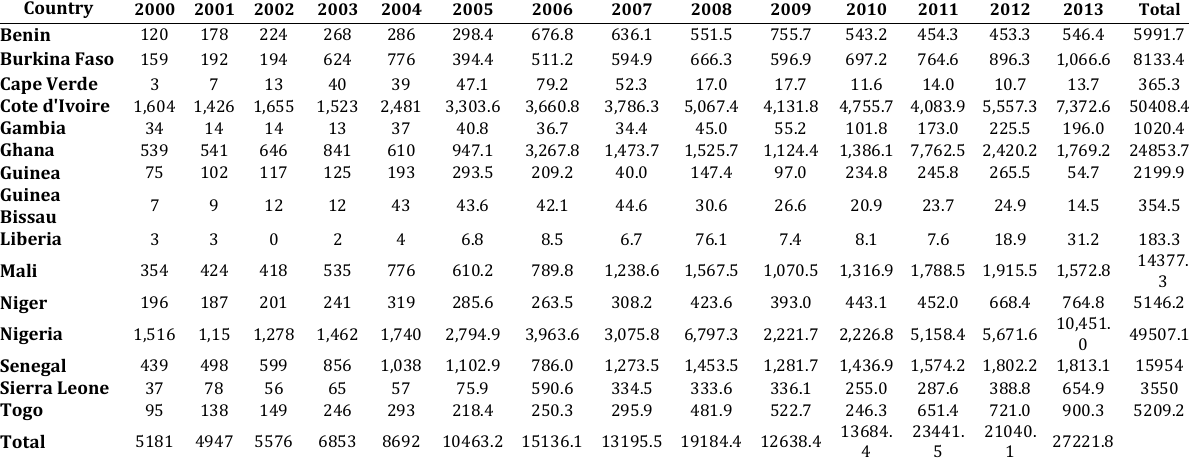
Table 2: Overall distribution of freight volumes in the ECOWAS sub-region (in million tonnes) from various modes of